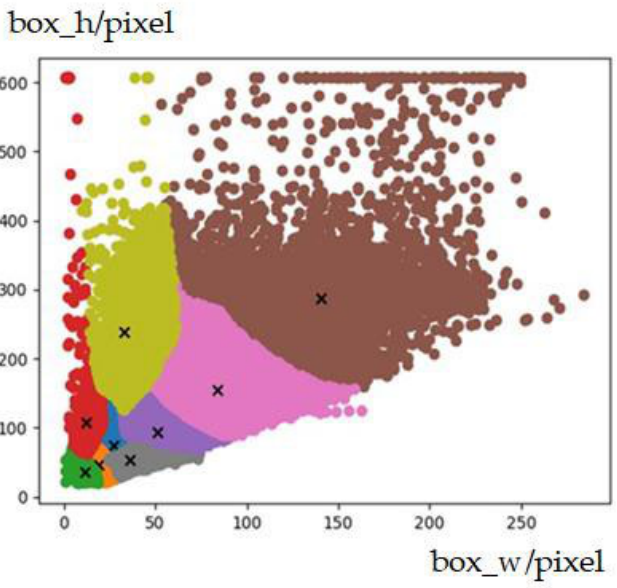
Figure 6. Cluster results of the improved K-means++ algorithm on the KITTI dataset.